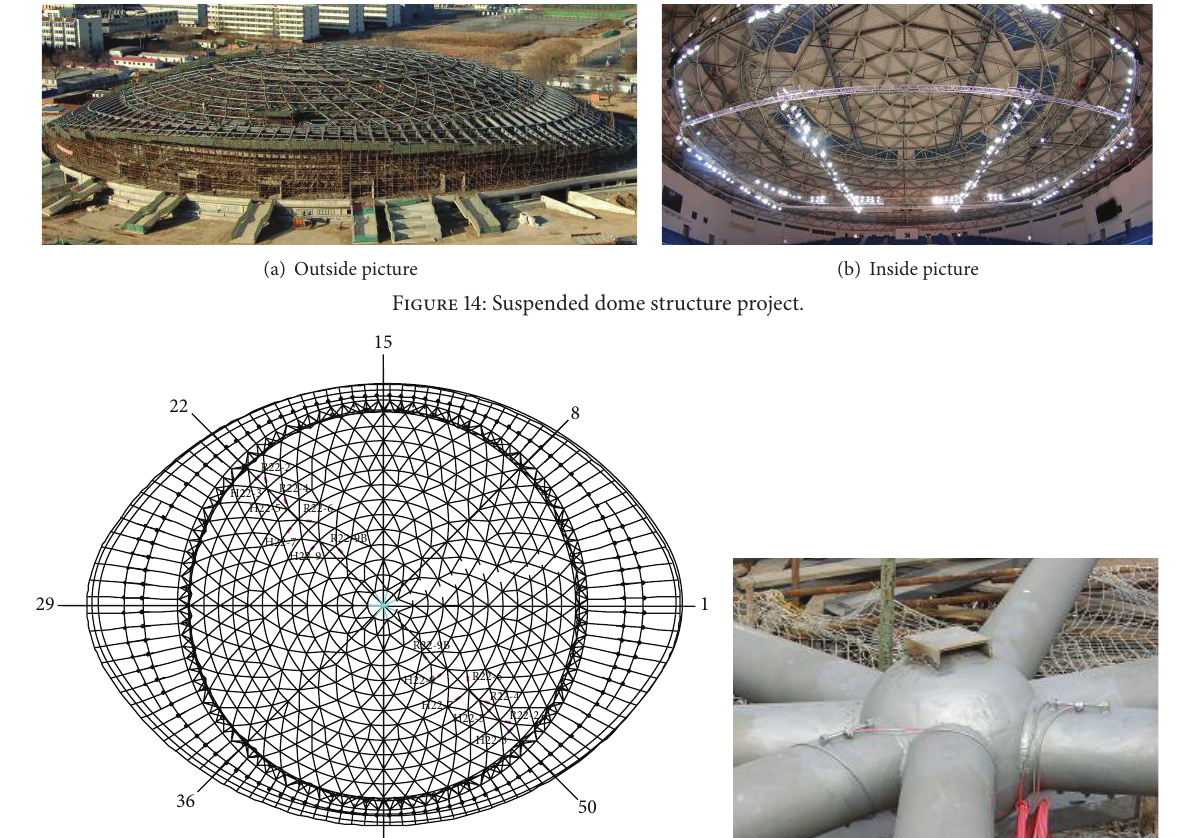
Figure 15: Layout of the vibrating wire sensor.